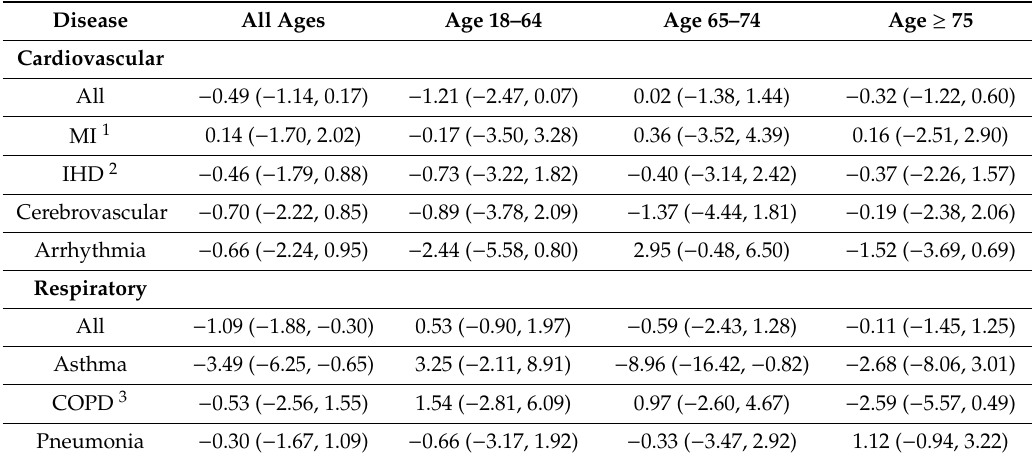
Table 4. Percentage change (95% CI) in daily hospital admissions for cardiorespiratory diseases associated with a 1 ◦ C increase in daily mean temperature during summer months (June–August) in the Helsinki metropolitan area, Finland,